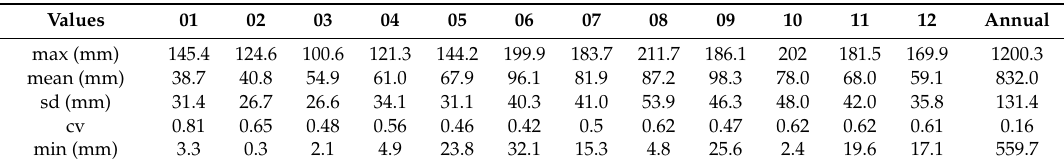
Table 2. The monthly and annual precipitation sum in Varaždin. Statistics in rows refer to maximum, mean, and minimum monthly and annual precipitation in the 1981–2010 period, the standard deviation (sd), and the coe ffi cient of variation (cv).